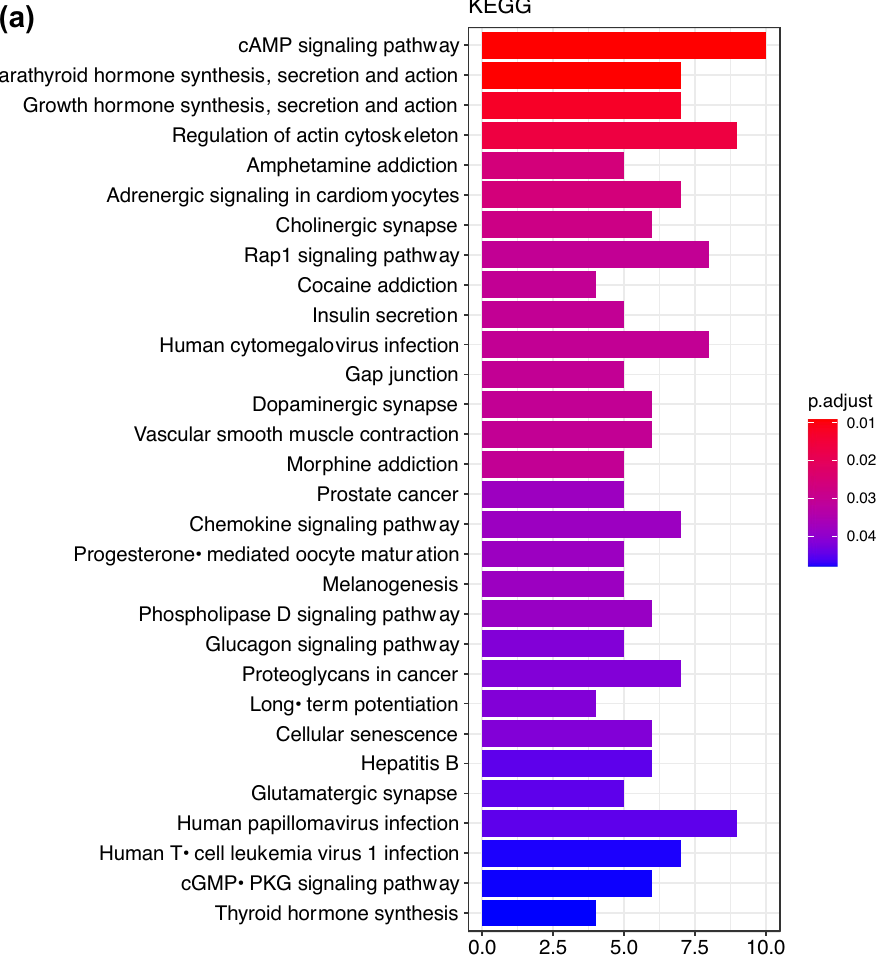
Figure 3. Gene set enrichment analysis of Log Creatinine. ( a ) Bar plot showing enriched KEGG pathways for quantitative renal trait Log Creatinine. Results of gene-set enrichment analysis (GSEA): Bar charts of significantly enriched KEGG pathways. Number of genes (n) corresponding to nominally associated LogCreat GWAS SNPs is represented on the x-axis with adjusted significance ( P < 0.05) indicated by order and colour trend. ( b ) Gene network plot for enriched KEGG pathways associated with the renal trait Log creatinine. Gene network plot showing identified feline genes (grey nodes) and overlap between enriched KEGG pathways for renal trait Log creatinine. Gold nodes represent top 5 enriched KEGG pathways including cAMP signalling, parathyroid hormone synthesis, secretion and action, growth hormone synthesis, secretion and action, regulation of actin cytoskeleton and amphetamine addiction where nodal size is proportional to the number of nominally associated LogCreat GWAS genes in each pathway. ( c ): Violin plots showing Log Creatinine by genotype for SNPs corresponding to genes of the top 4 pathways enriched in GSEA. cAMP; cyclic adenosine monophosphate pathway, cytskel; cytoskeleton pathway, hormone; parathyroid hormone and growth hormone pathways, HOM A1; homozygous allele 1, HOM A2; homozygous allele 2, HET; heterozygous, LogCreat; Log creatine. ( d ) Violin plots of Log Creatinine by genotype for the most striking SNPs corresponding to RDX and MAPK1 from top enriched GSEA pathways. HOM A1; homozygous allele 1, HOM A2; homozygous allele 2, HET; heterozygous, LogCreat; Log